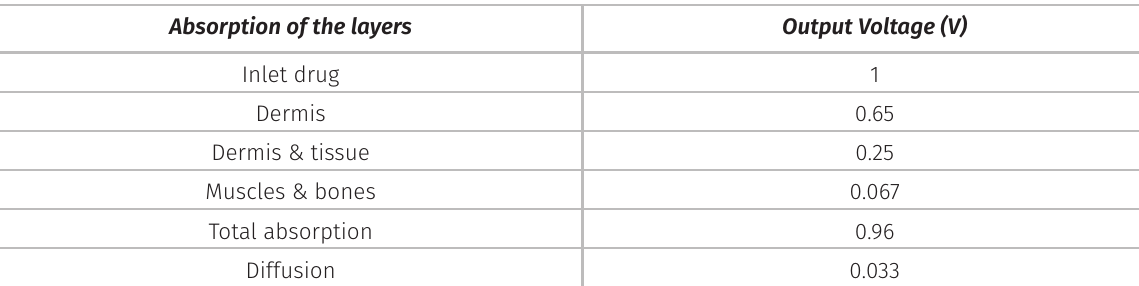
Table III. Absorption by the layers of the skin.